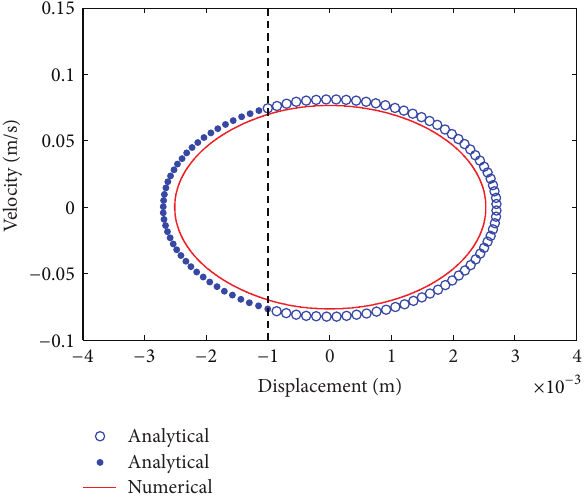
Figure 7: Comparison of the periodic orbits from approximate analysis and numerical methods at 𝜔 = 30